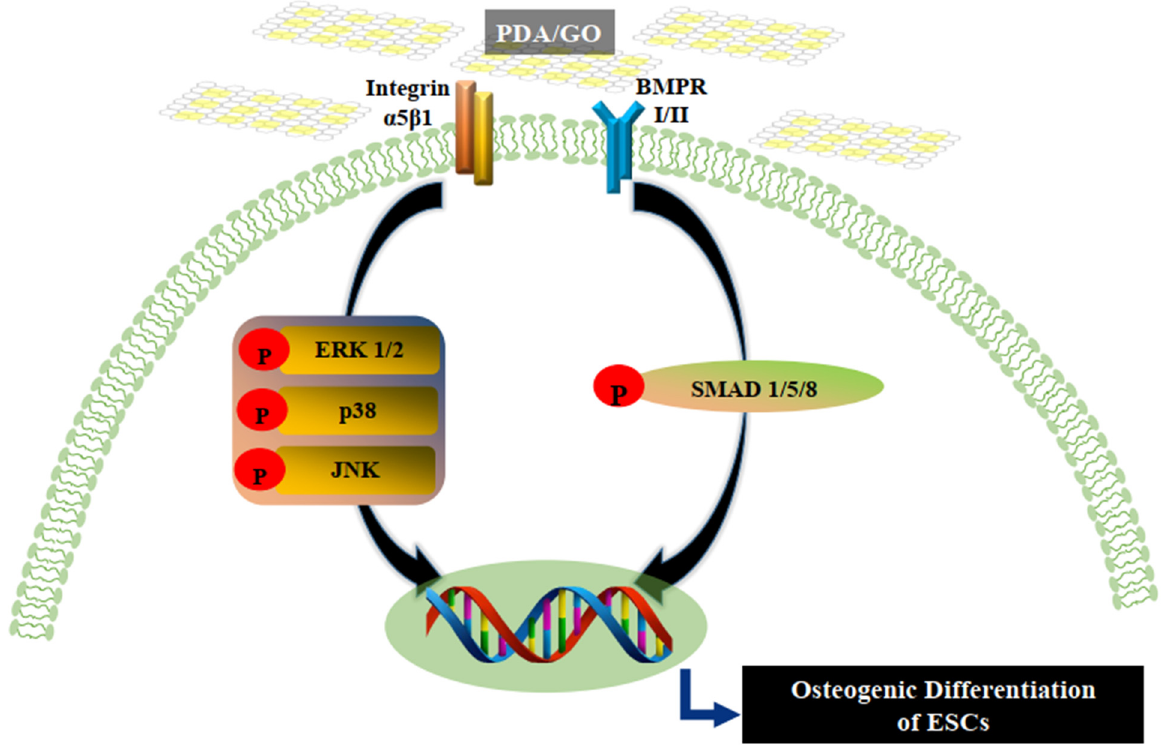
Figure 7. Hypothesized model of the PDA/GO-mediated osteogenic differentiation of ESCs. When ESCs are cultured on PDA/GO-modified surfaces, integrin α 5/ β 1 and BMPR I/II are recognized, leading to MAPK or SMAD signaling pathway activation and eventually promoting the osteogenic differentiation of ESCs.